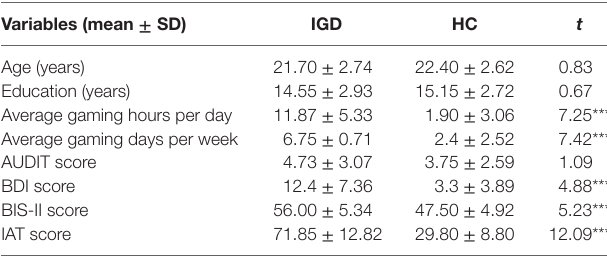
TaBle 1 | Demographic and clinical characteristics of the IGD group and